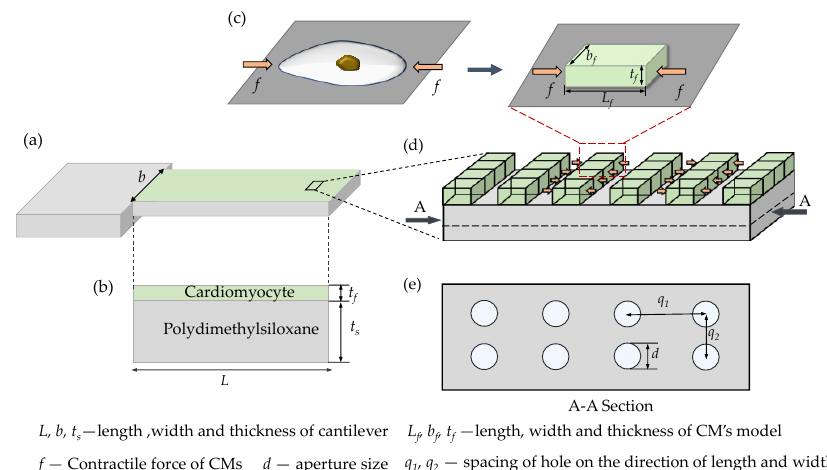
Figure 1. Molding of the perforated microcantilever covered with a layer of cardiomyocytes (CMs): ( a ) 3D structure of the perforated microcantilever covered with a layer of CMs; ( b ) side view of ( a ); ( c ) equivalent model of the CMs; ( d ) top view of (a); ( e ) a section of (d). The CM layer consists of a thin film attached to the surface of the plain microcantile- ver. The contractile force of the CMs is equivalent to the residual stress of the thin film. Based on this model, Stoney’s equation is used to calculate the free-end deflection of the plain microcantilever, as shown in Equation (1) [26,27].